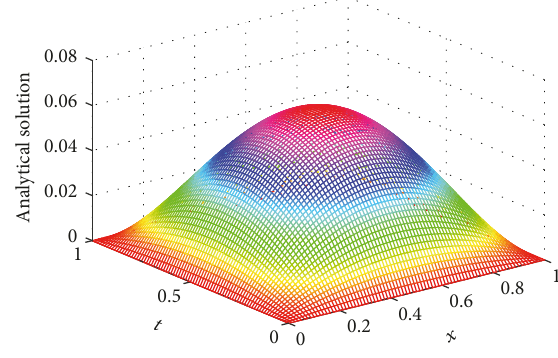
Figure 2: Analytical